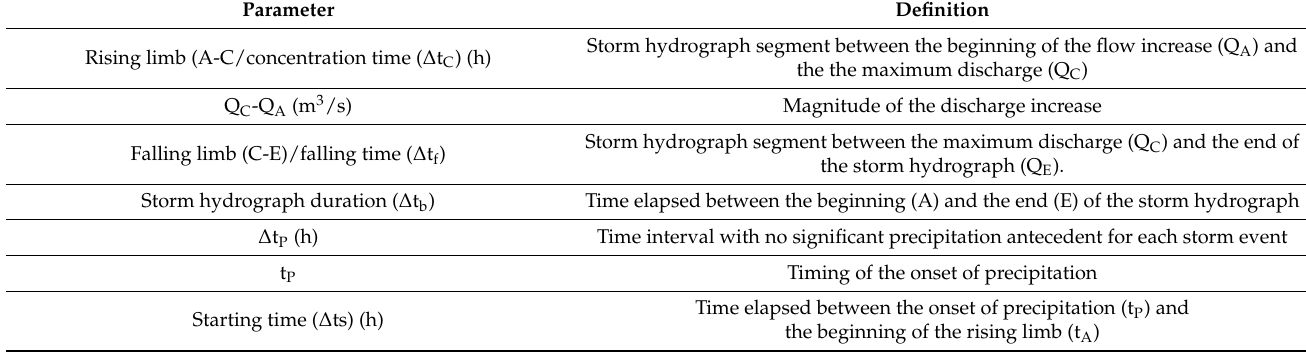
Table 1. Storm hydrograph, thermograph, and chemograph parameters considered in this study. The most important parameters are described in Figure 3, whereas the complete list with the values for each of them is provided in the Supplementary Material